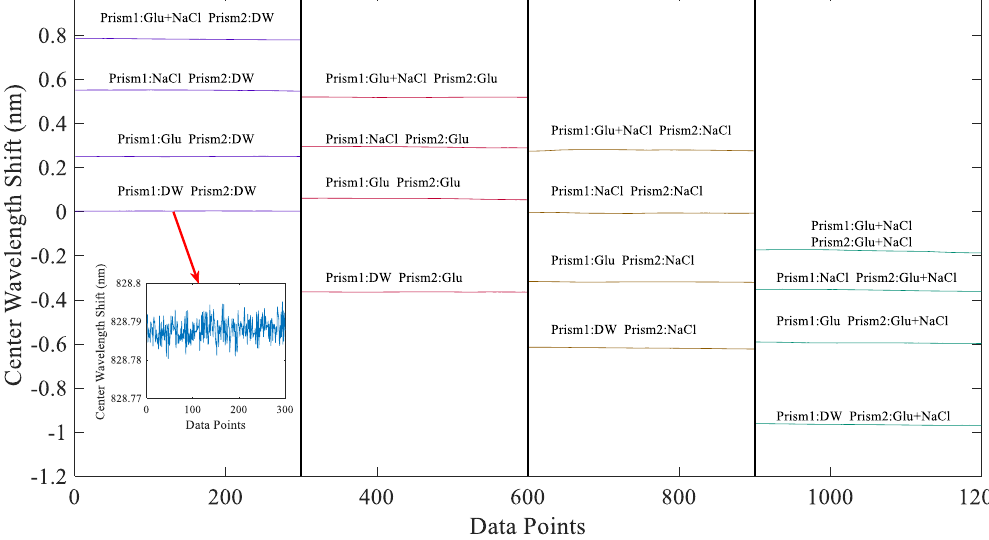
Figure 6. When a different solution is introduced into the flow paths of prism 1 and prism 2, the center wavelength of the system shifts. The inset is the central wavelength at which the deionized water is simultaneously introduced into the flow paths of prism 1 and prism 2. Table 1. The value of the system center wavelength shift amount when a different solution is passed through the flow path of prism 1 and prism 2. DW: deionized water.